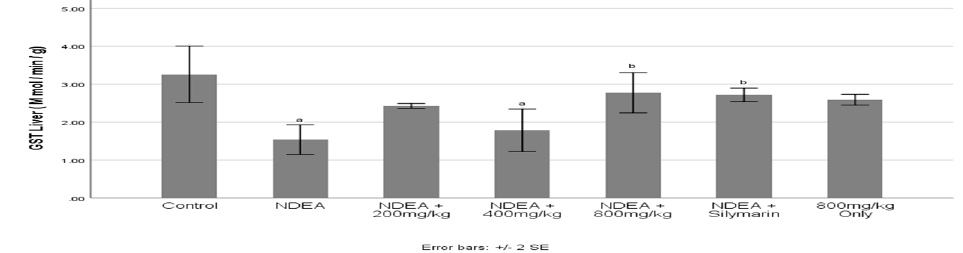
Figure 5. Effect of Cajanus cajan on Glutathione S-transferase (GST) activity. Values are expressed as mean ± SEM; a Values differ significantly from the control group; b Values differ significantly from the NDEA-treated group.